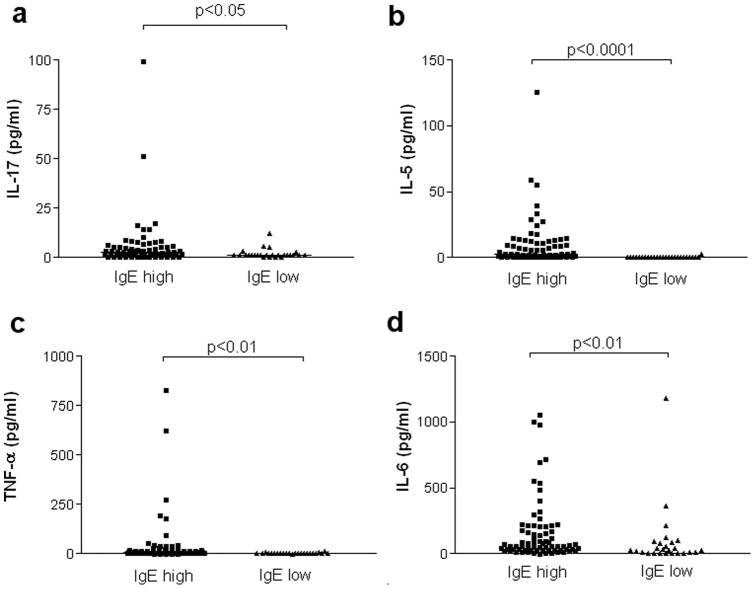
Cytokine levels in “IgE high” and “IgE low” asthmatics.